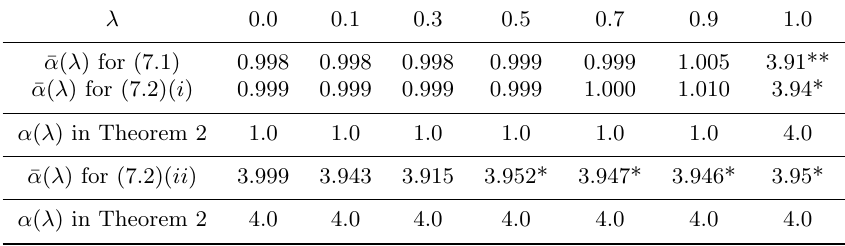
Table 3. ¯ α ( λ ) ≈ α ( λ ) for γ o sampled as in (7 . 1) and (7 . 2) with m ∈ { 72 ,..., 162 } . λ 0.0 0.1 0.3 0.5 0.7 ¯ α ( λ ) for (7 . 1) ¯ α ( λ ) for (7 . 2)( i